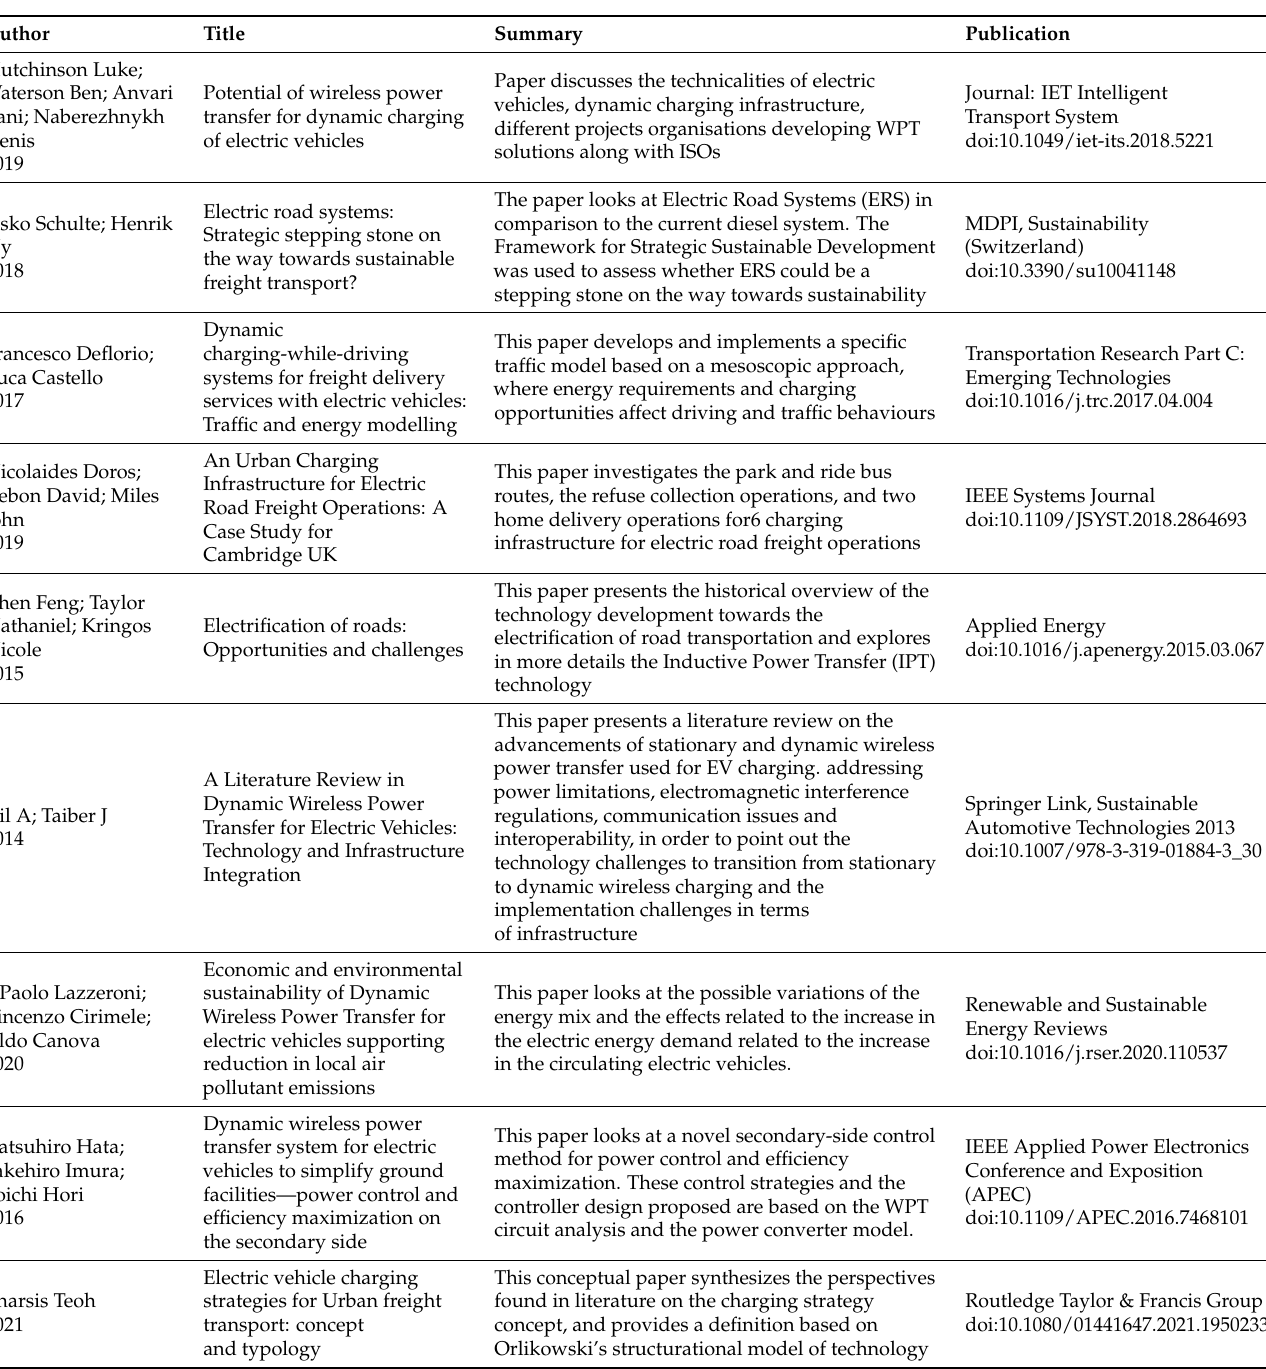
Table A1. Summary of literature regarding Dynamic Wireless Power Transfer (DWPT) an electric road system